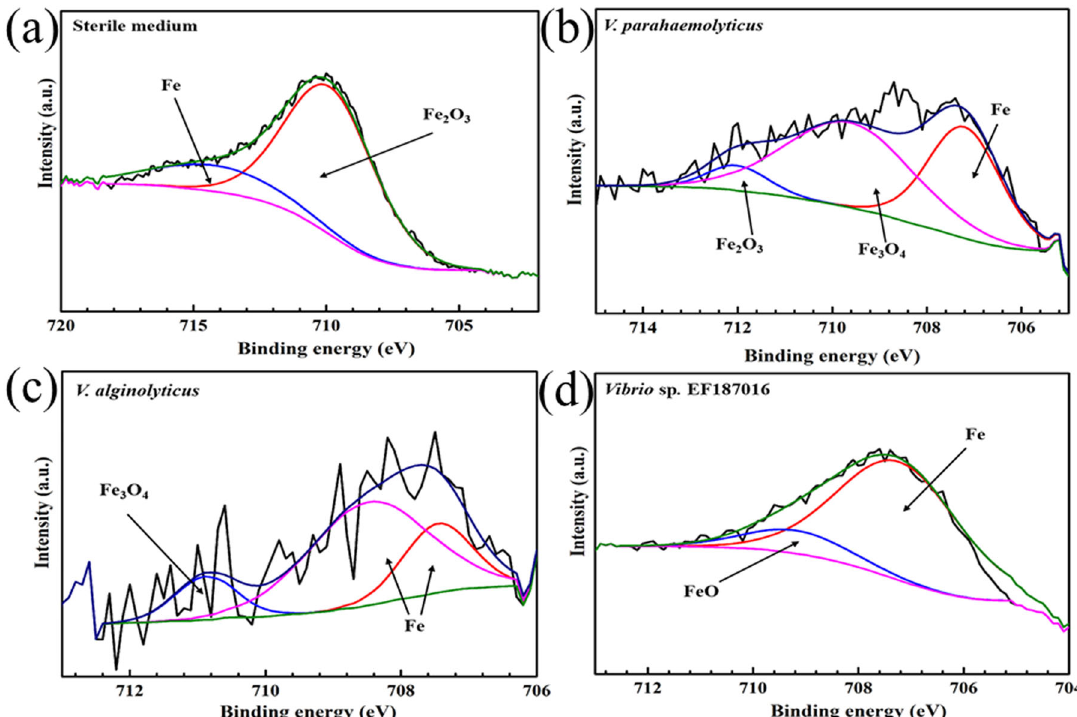
Fig. 5 Fe 2p fi ne XPS spectra of X80 coupons after 14 d. a Sterile medium, b V . parahaemolyticus , c V . alginolyticus , and d Vibrio sp .